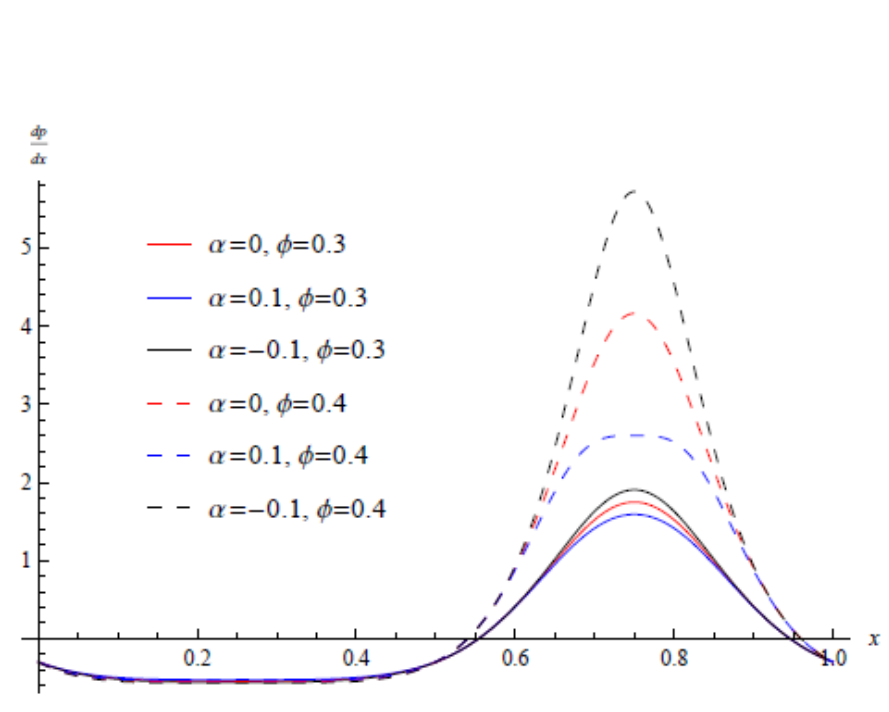
Fig. 6 (b). Pressure gradient for various values of , 